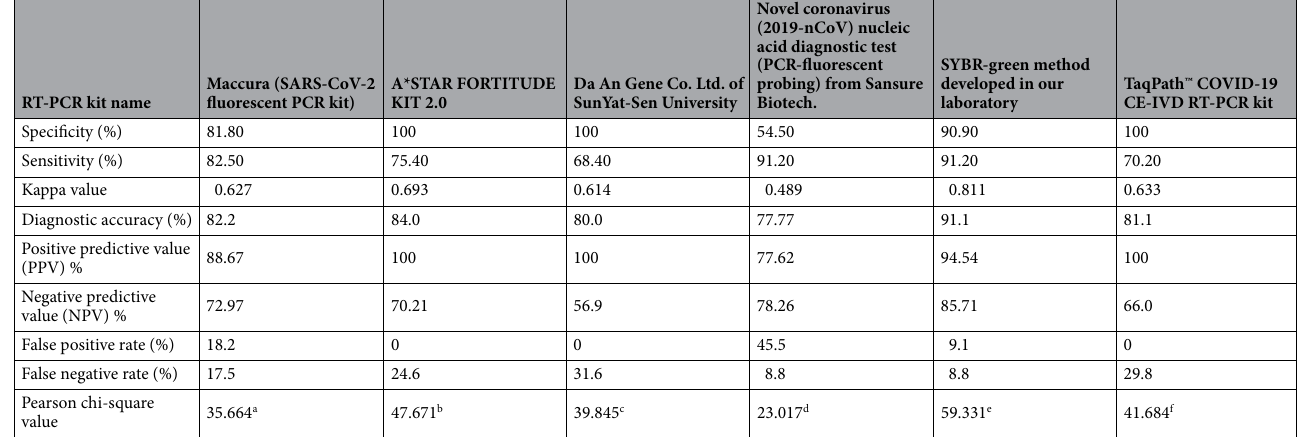
Table 4. Sensitivity and specificity test result for different RT-PCR kits. For Pearson’s chi-square test the P value (Asymptotic Sig. value-2 sided) was < 0.001. a 0 cells (0.0%) have expected count less than 5.